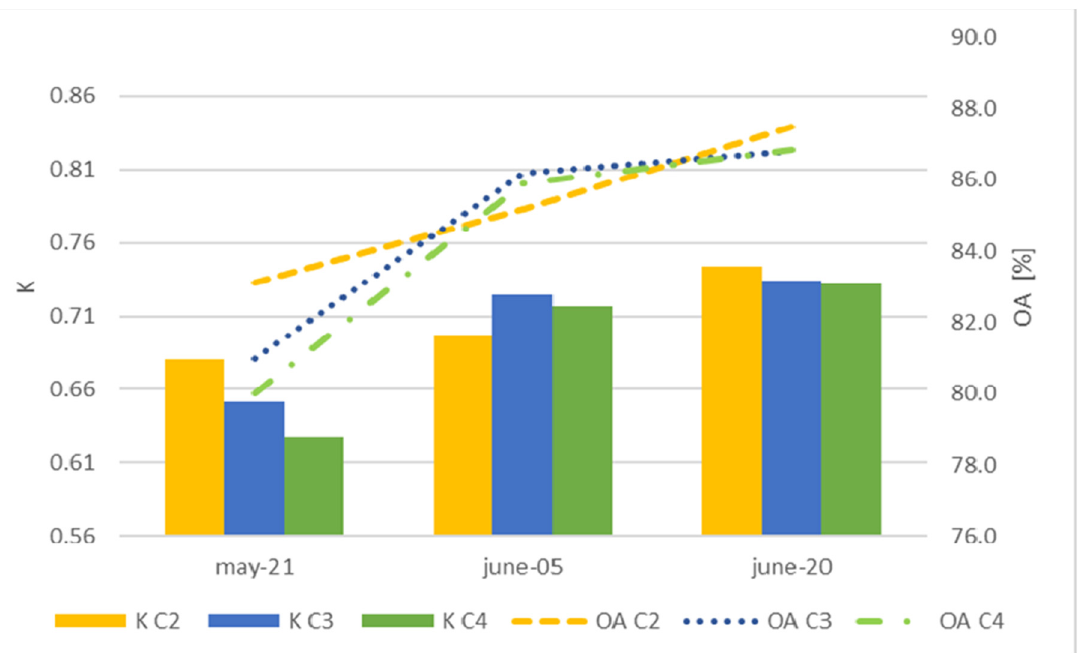
Figure 12. Overall accuracy (OA) and kappa coefficient (K) for each combination used. C2: 2 scenes every 30 days (about 4 and a half weeks). C3: 3 scenes every 15 days. C4: 2 scenes every 15